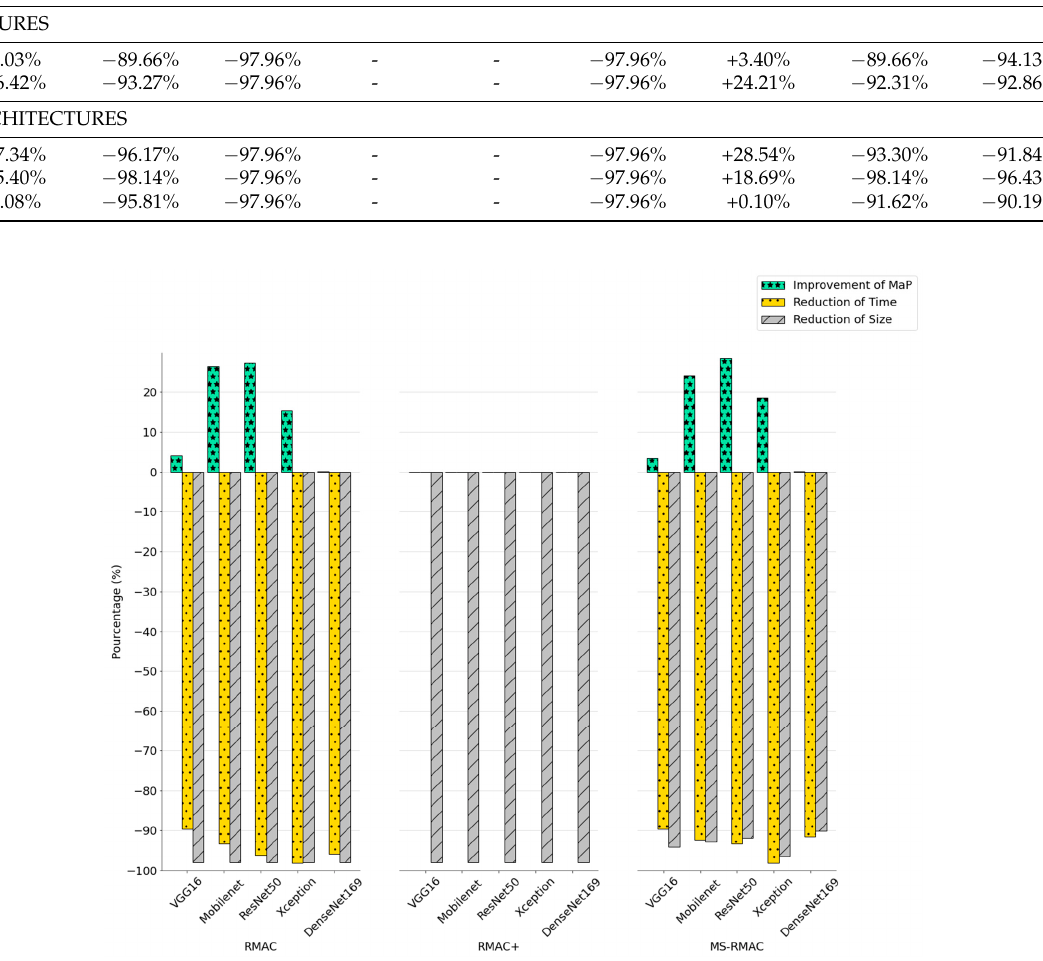
Table 7. Comparison of improvements based on the increase in MaP, reduction in search time, and vector size (in %). RMAC RMAC+ MS-RMAC Improv. ImproV. Red. Improv. Red. Time Red. Size Red. Size Red. Time Red. Size Map Map Time Map